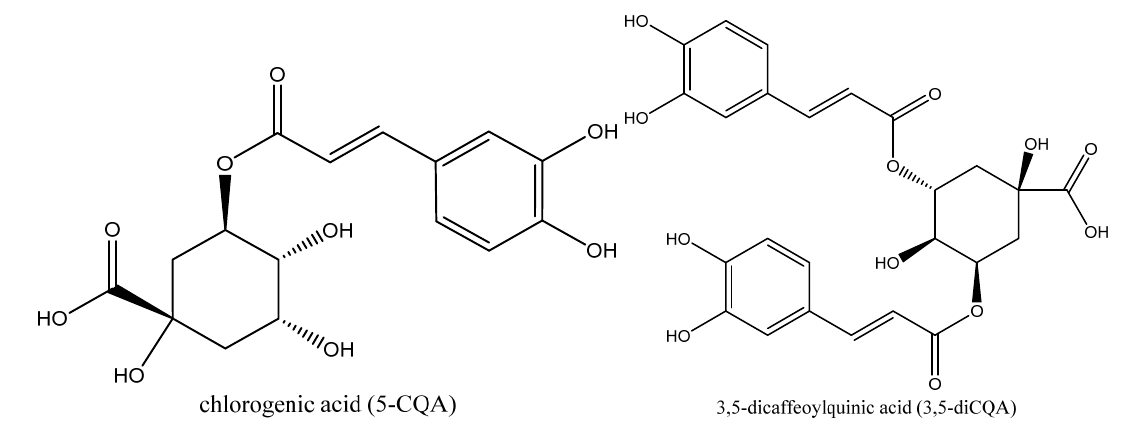
Figure 1. Chlorogenic acid (5-CQA) and 3,5-dicaffeoylquinic acid (3,5-diCQA) .